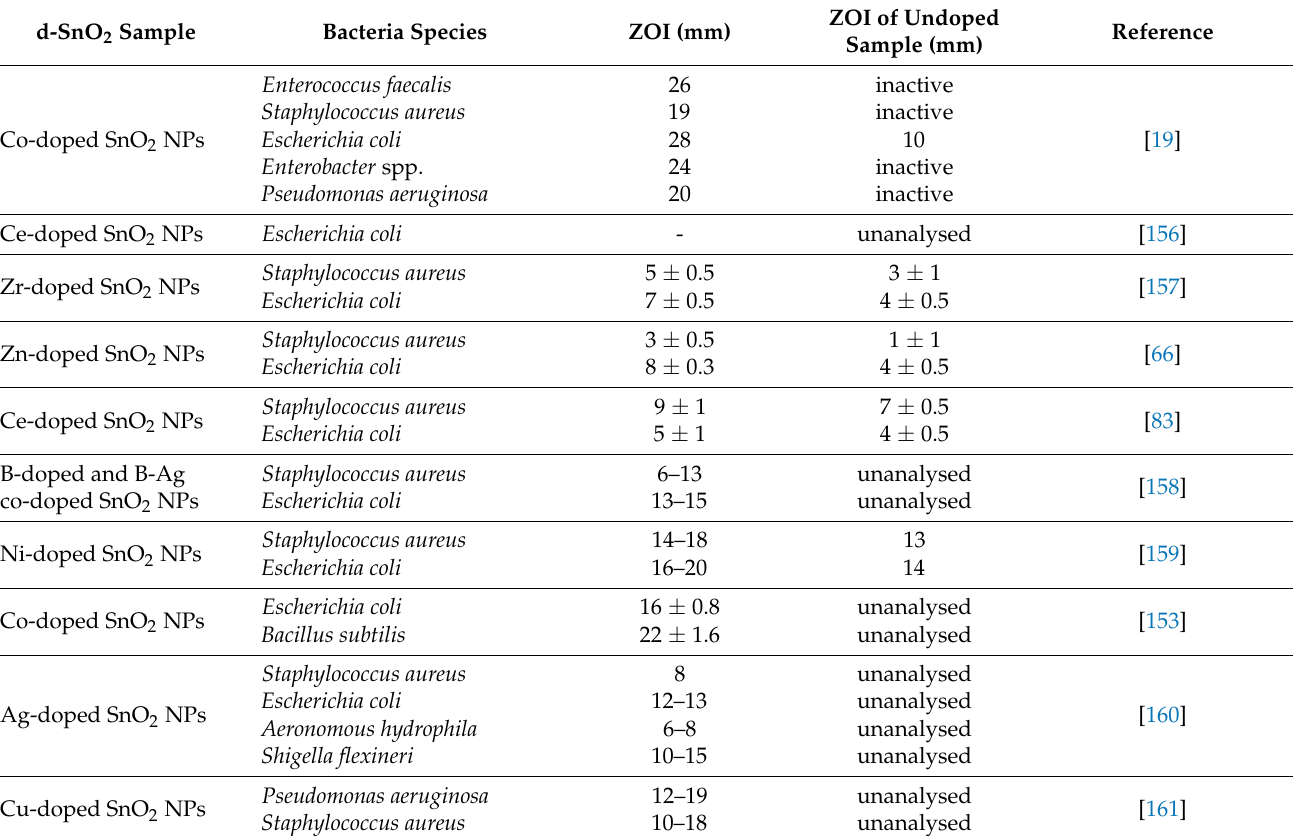
Table 2. d-SnO 2 samples for which antibacterial activity through ROS production has been